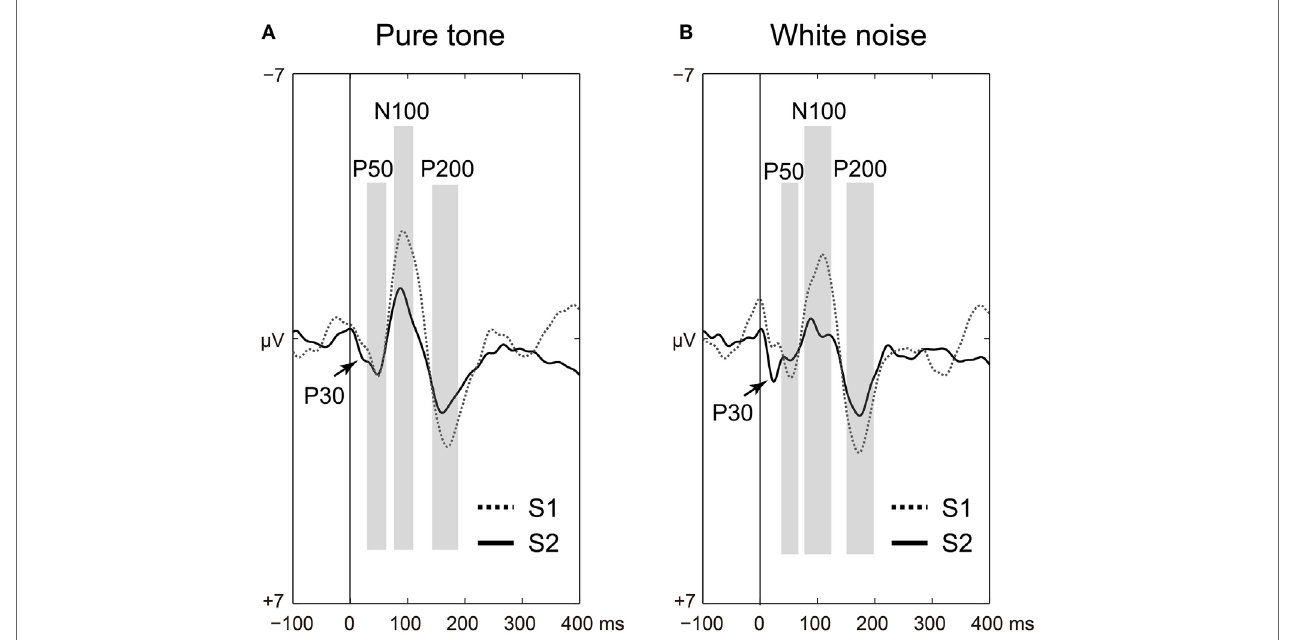
FigUre 2 | Time-domain analyses of the first (s1: broken line) and second (s2: solid line) stimuli compared for (a) pure tones and (B) white noise . Auditory-evoked potential components (P50, N100, and P200) are shaded in light gray. Irrespective of stimulus type, sensory gating (reduced S2 amplitudes from preceding troughs to peaks) is significantly observed in all of P50, N100, and P200 ( ps <